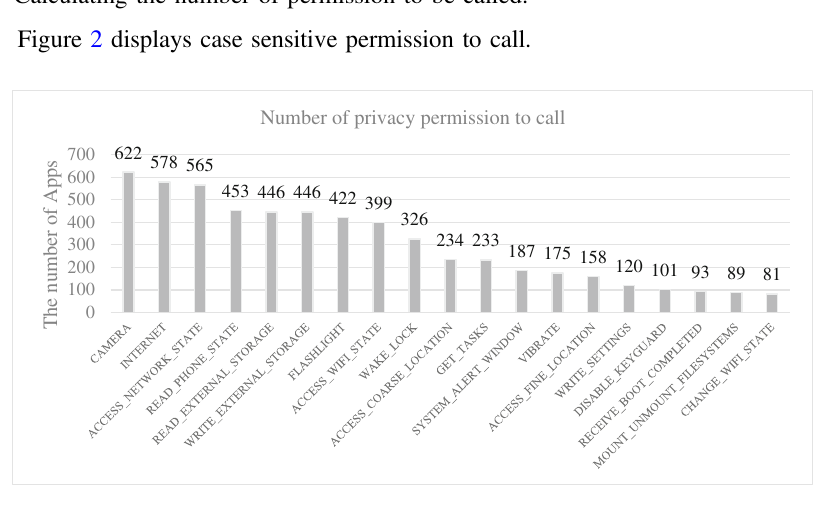
Fig. 2. Number of privacy permission to